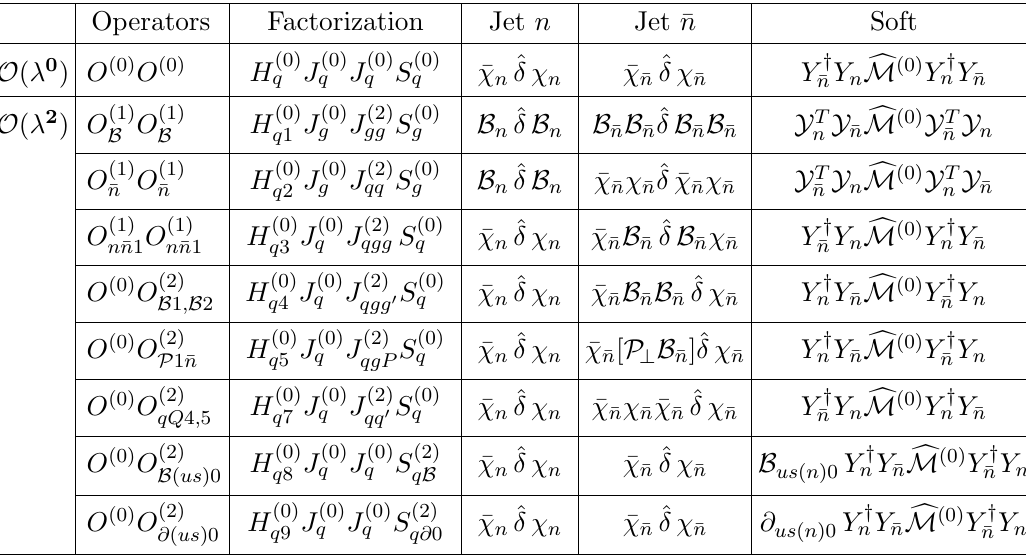
Table 5. Subleading jet and soft functions arising from products of hard scattering operators in the factorization of dijet event shapes and their (cid:12)eld content. Helicity and color structures have been suppressed. We have not included products of operators whose jet and soft functions are identical to those given in the table by charge conjugation or n $ (cid:22) n